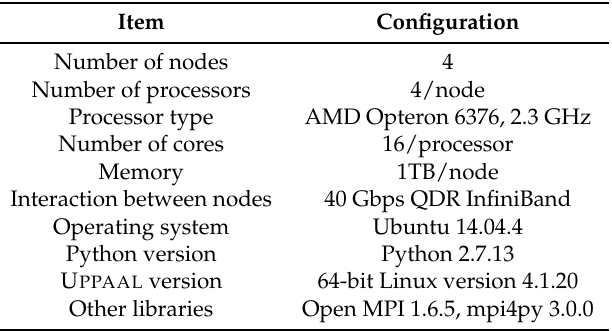
Table 1. The configuration of the experimental